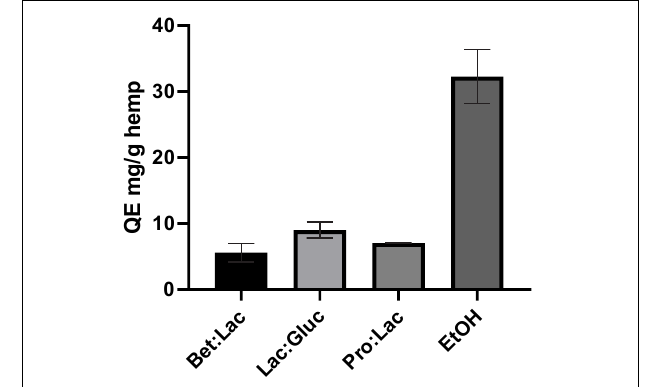
FIGURE 3 | Total phenolic content related to the different solvents tested and expressed in mg GAE/g hemp (extraction conditions: 60 ◦ C, 90 min, and a 1:10 S/L ratio).